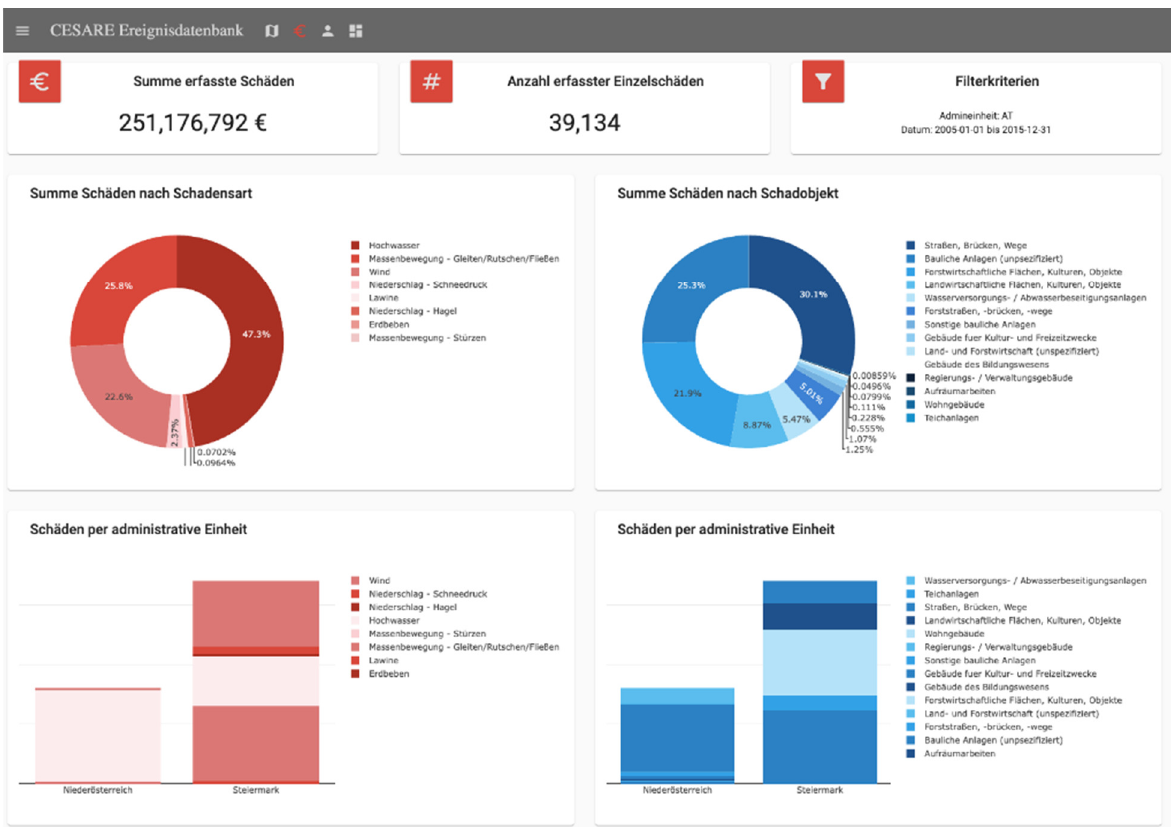
Figure 7. Snapshot of the CESARE demonstrator dashboard service for economic losses.